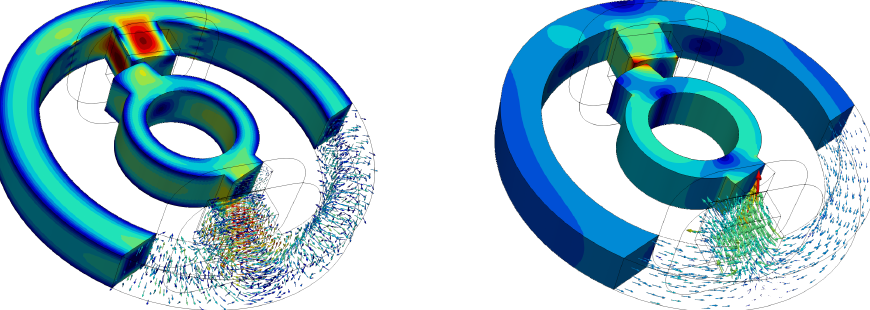
Figure 7. TEAM 24 result snapshots for induced currents at t = 0.03s ( left ) and the B -field at t = 0.3s ( right ).